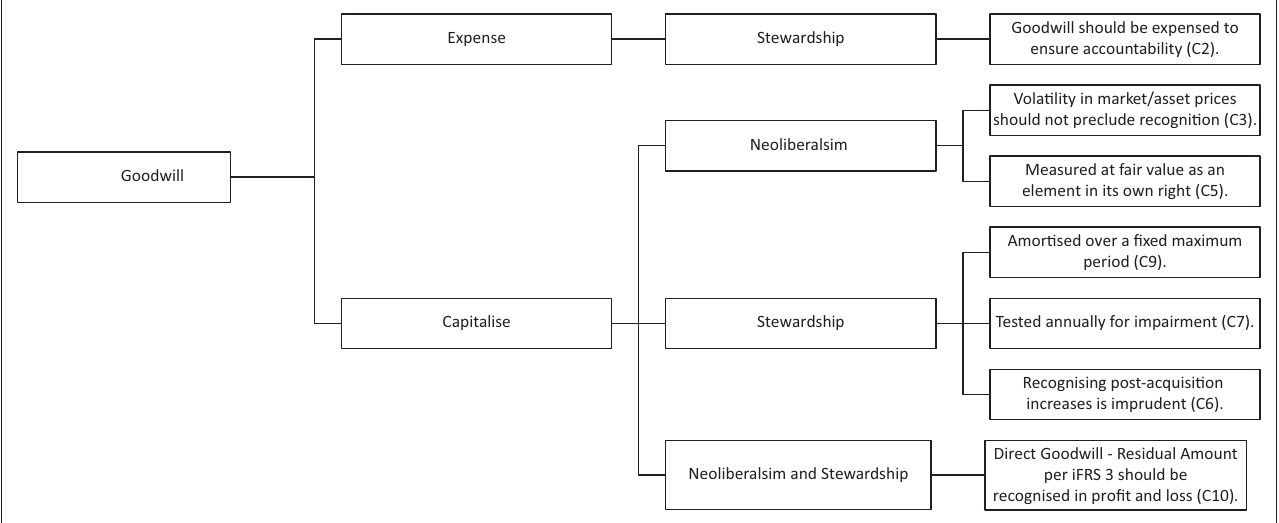
FIGURE 2: Summary of accounting